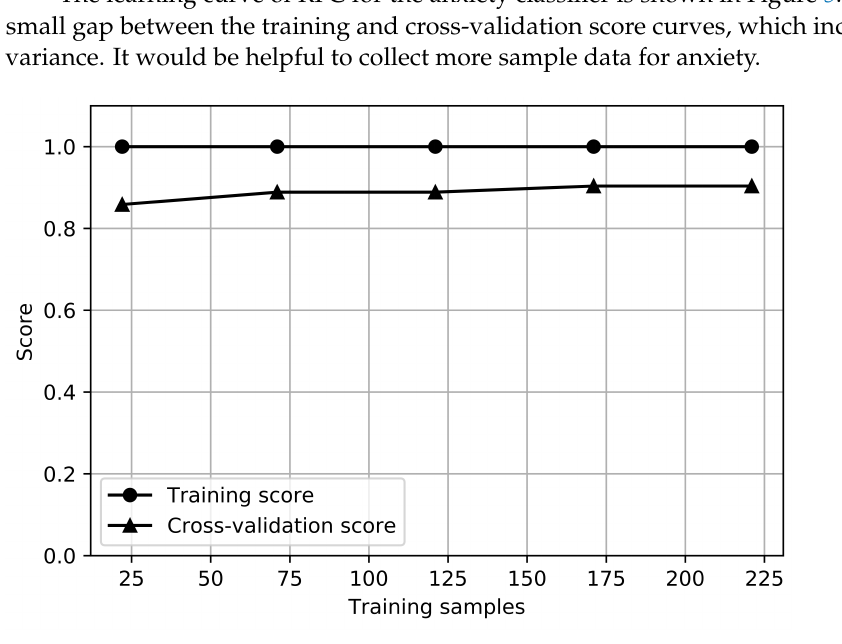
Figure 5. Learning curves of anxiety classifier.